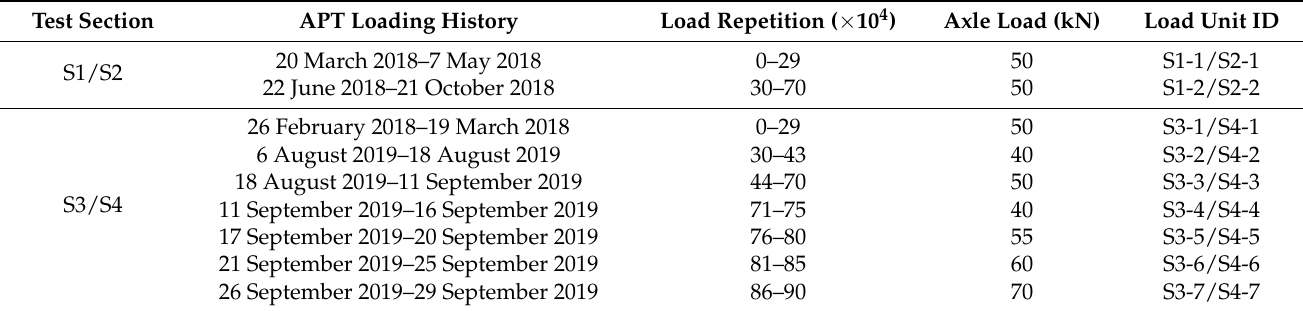
Table 1. APT loading history division results of the four test sections S1–S4 for the rutting analysis. APT Loading